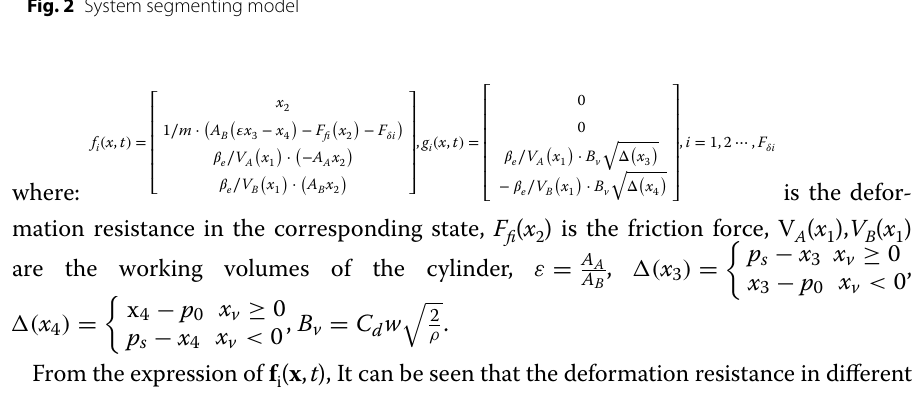
Fig. 2 System segmenting